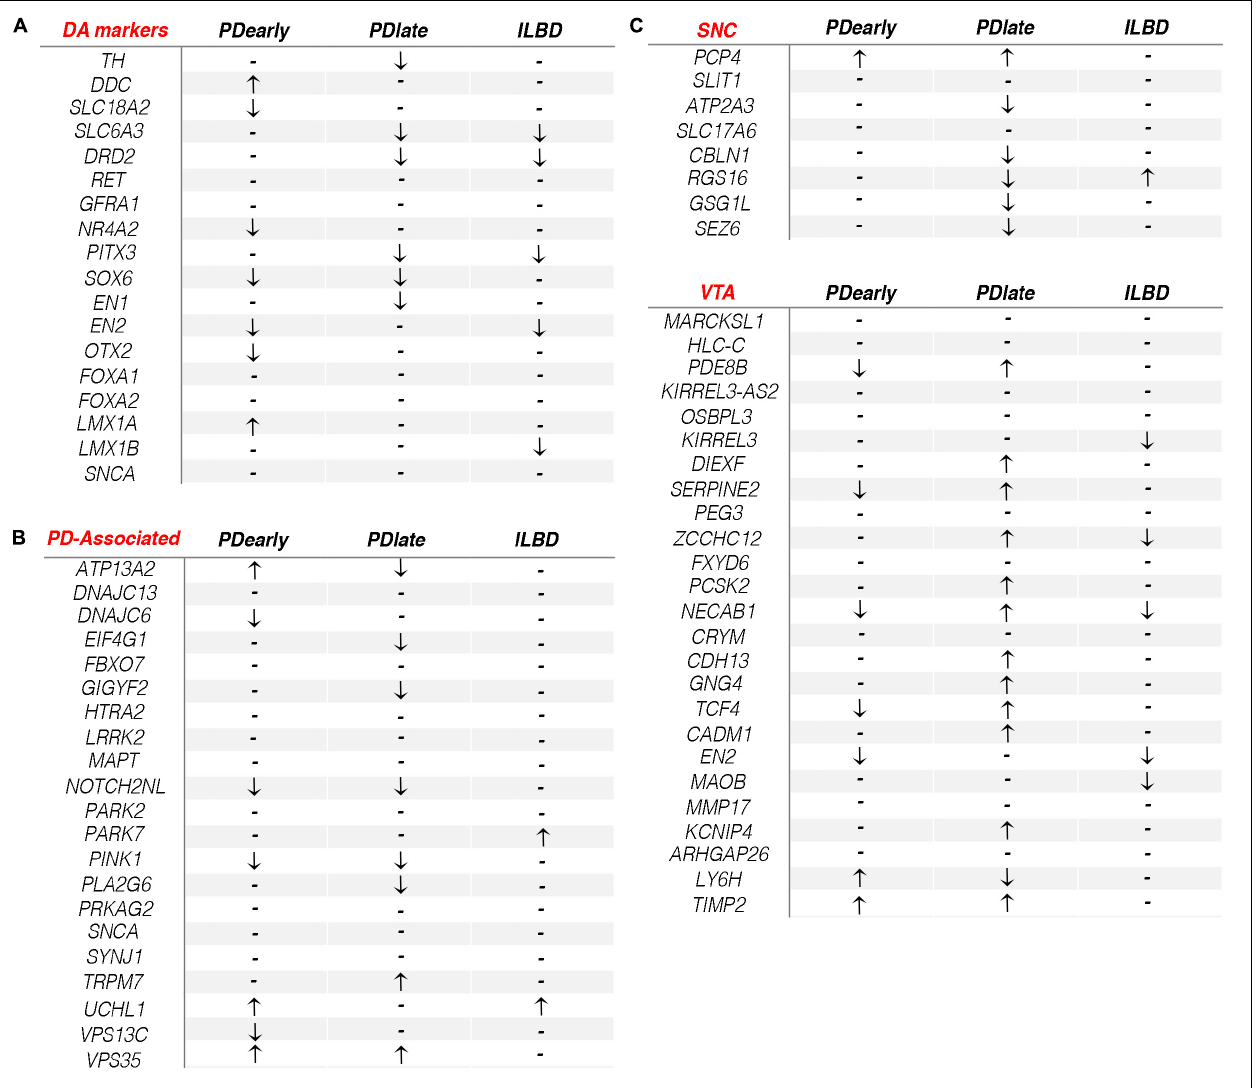
FIGURE 5 | Dopamine related gene expression changes in PDearly, PDlate and incidental Lewy body disease. (A–C) Arrows indicate significant (padj < 0.05, RPKM in controls > 1) up- or down-regulation of typical DA markers (A) , PD-associated genes (B) and SNC/VTA genes (C) in PDearly, PDlate and incidental Lewy body disease samples. Hyphen indicates nonsignificant